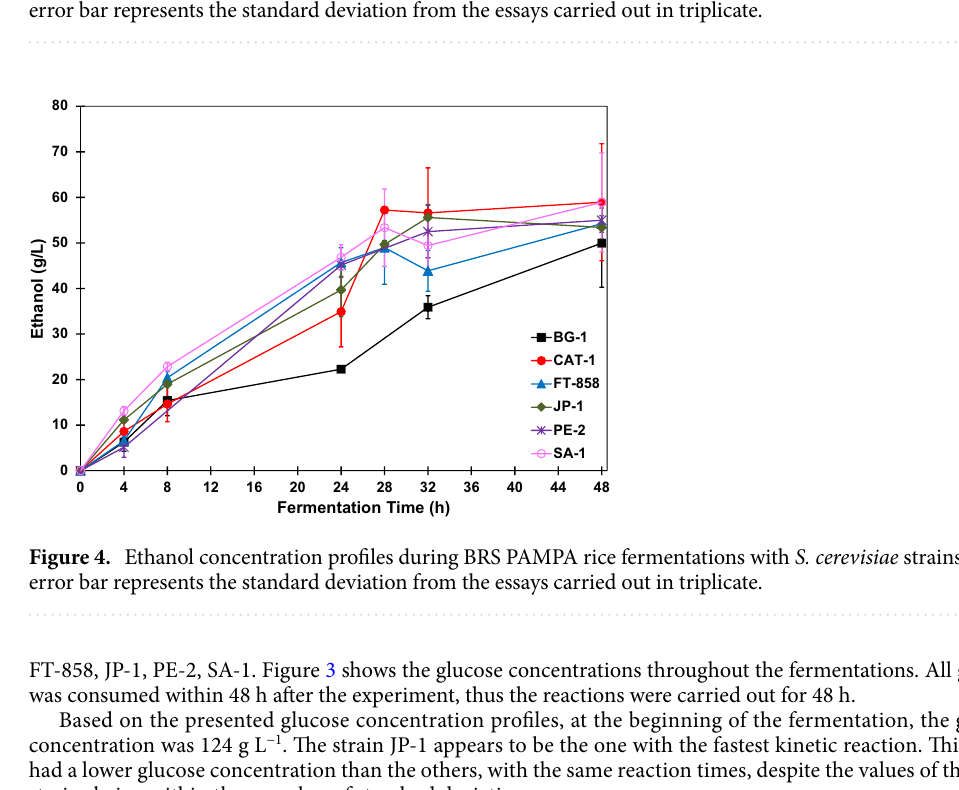
Figure 3. Glucose concentration profiles during BRS PAMPA rice fermentations with S. cerevisiae strains. The error bar represents the standard deviation from the essays carried out in triplicate.